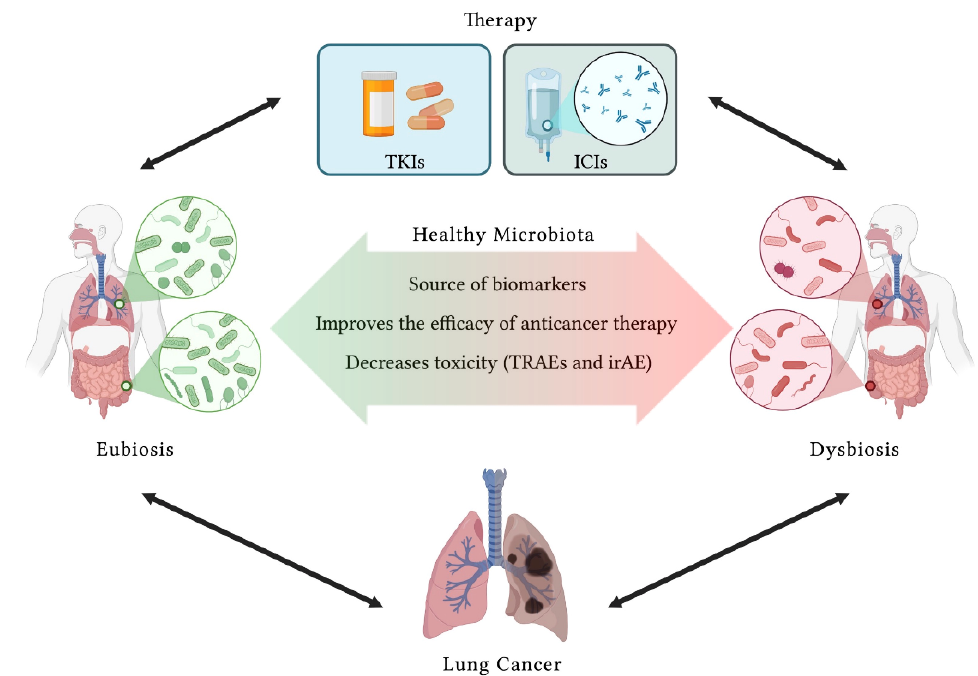
Figure 3. Positive roles of healthy gut and lung microbiota in lung cancer patients treated with tyrosine kinase inhibitors (TKIs) and/or immune-checkpoint inhibitors (ICIs). Lung and gut microbiota influence the response to targeted therapies and ICIs. The analysis of gut and lung microbiota composition could be a reliable source of diagnostic and prognostic biomarkers for LC. Eubiosis (microbial balance) versus dysbiosis (microbial unbalance) significantly influences the efficacy and toxicity of both TKIs and ICIs in lung cancer. The positive modulation of gut and lung microbiota is associated with the improvement of the efficacy of anticancer therapies and a decreased incidence of therapy-related adverse events (TRAEs) and immune-related adverse events (irAEs).